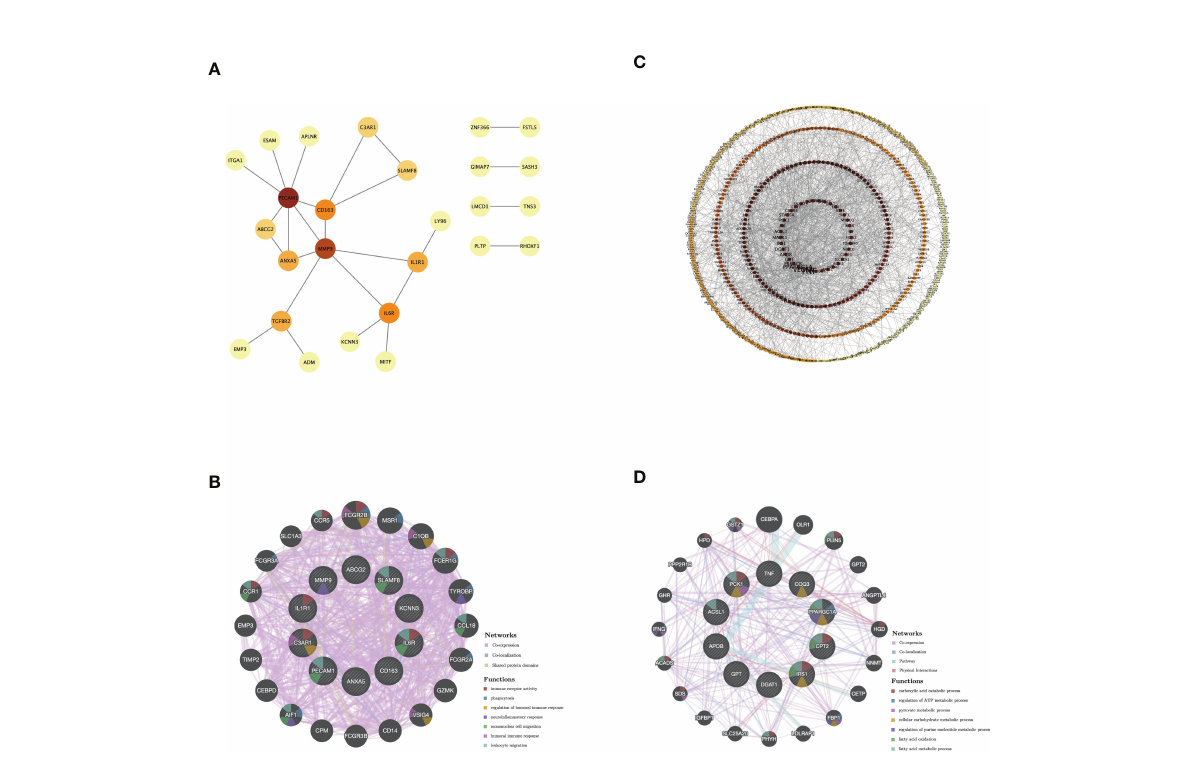
FIGURE 4 PPI network and co-expression network of hub genes. (A) PPI network diagram of GS1-UP. (B) GeneMANIA analysis of hub genes and their co- expression genes in GS1-UP. (C) PPI network diagram of GS1-DOWN. (D) GeneMANIA analysis of hub genes and their co-expression genes in GS1-DOWN. GS1, gene set